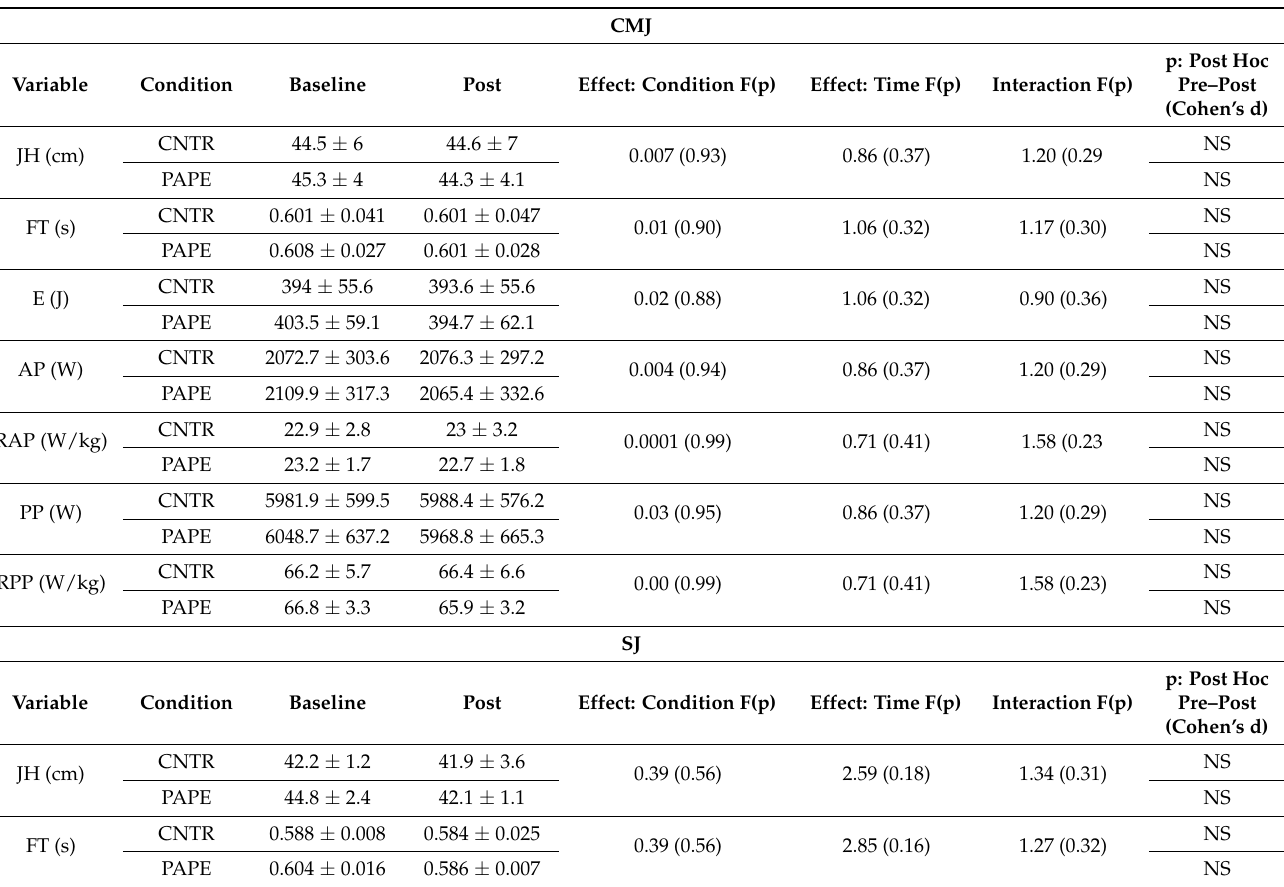
Table 3. Results of jumping tests for non-responders (six participants in CMJ, three in SJ) at the baseline and after CA (presented as mean ±